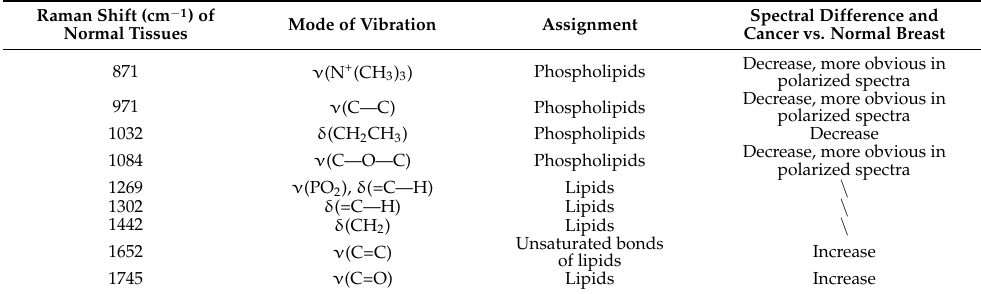
1745 ν (C=O) Lipids Increase Note: ν -stretching coordinate; δ -deformation; γ t -twisting